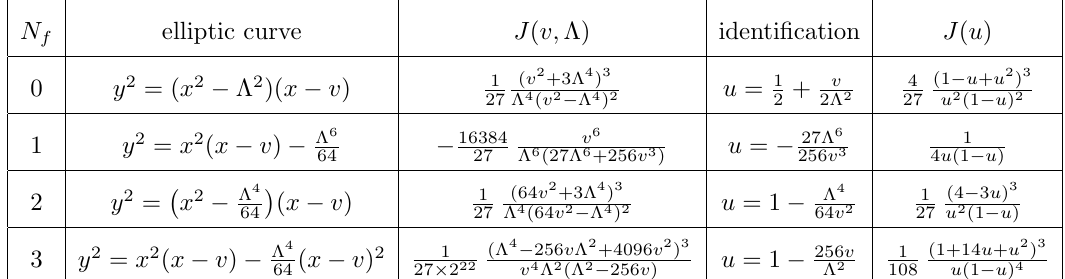
Table 5 . Elliptic curves for the SU(2) N = 2 SUSY quantum (cid:12)eld theories with N f massless (cid:13)avors of matter (cid:12)elds, and the associated modular J functions. Comparisons with the J functions in tables 4 and 6 from the uniformization of the elliptic curves for the arithmetic Chebyshev potentials leads to the identi(cid:12)cations in (3.75), (3.76),